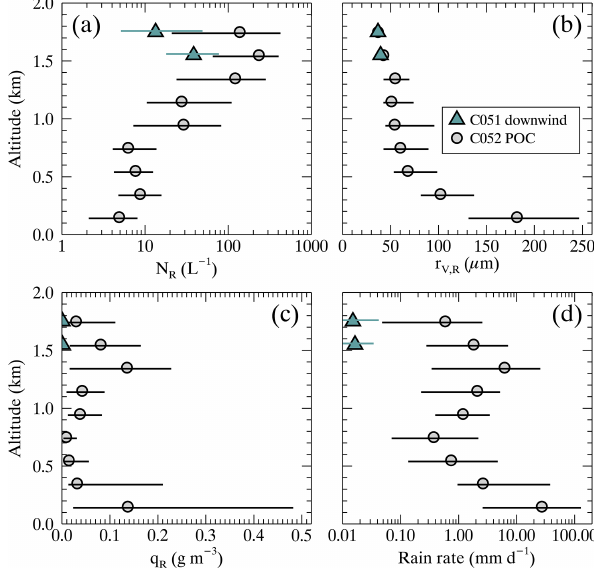
Figure 10. Composite vertical profiles of (a) cloud drop number concentration, (b) volume mean radius of cloud drops and (c) cloud liquid water content. The filled symbols are the median and the hor- izontal bars the interquartile range of the in-cloud data. Panel (d) shows vertical profiles of the cloud (filled symbols) and rain (open symbols) fraction from the measurements along the flight track. Cloudy points are defined when the CDP LWC > 0.01gm − 3 and rain points when the concentration of drops larger than 60µm ex- ceeds 1L − 1 .